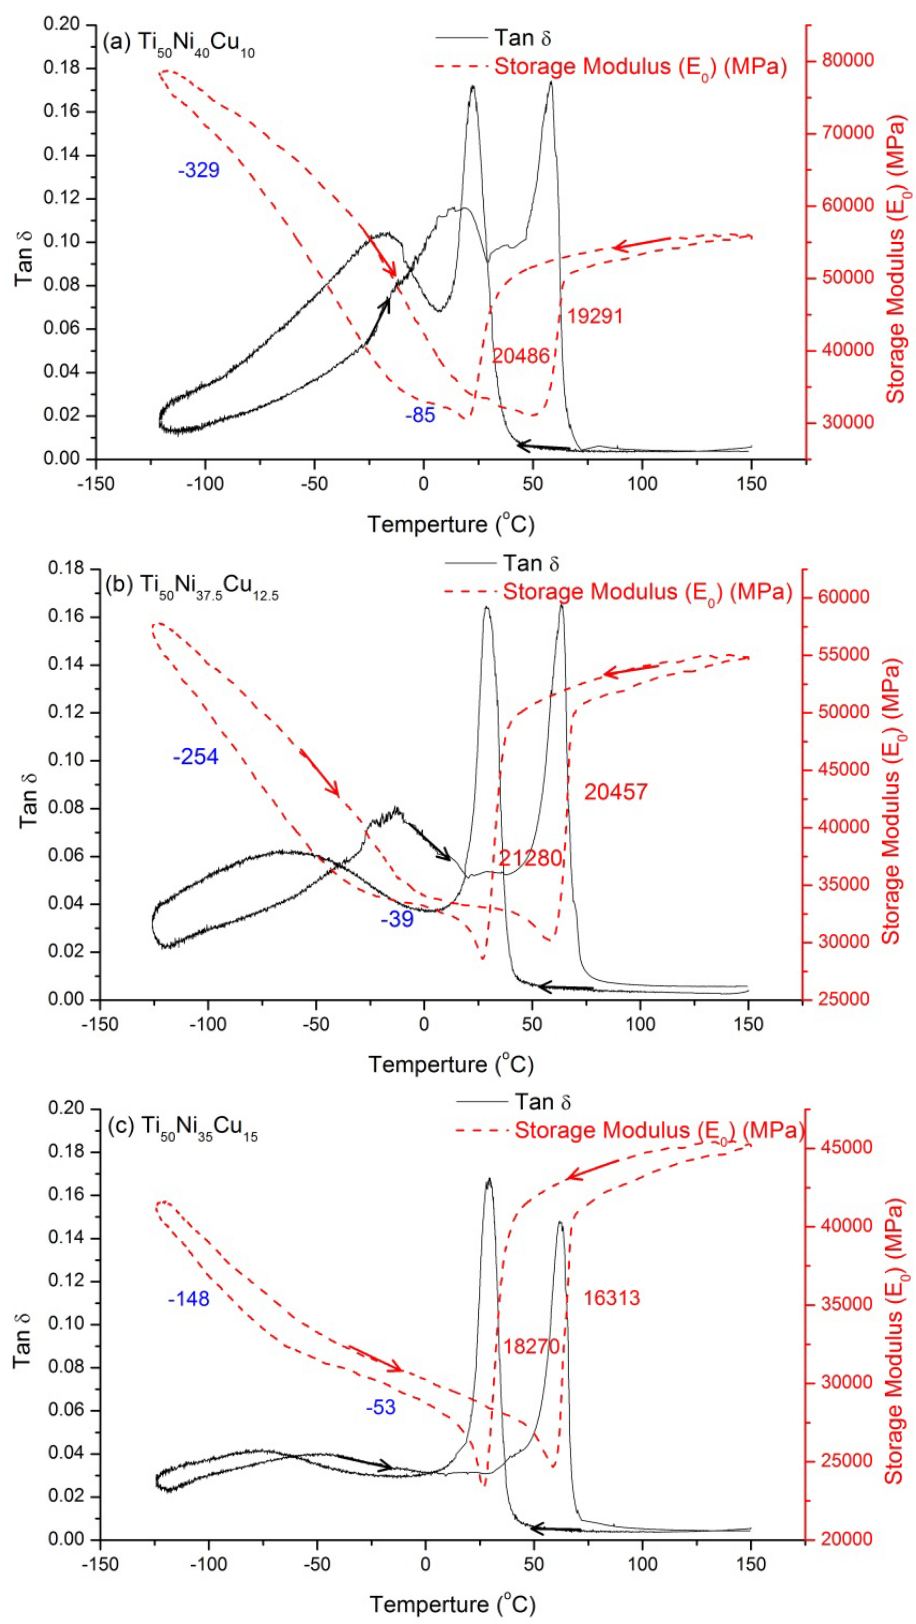
) curves for Ti Ni Cu SMAs. 0 50 50 − x x slopes in B19’ and B19 0 softening and 0